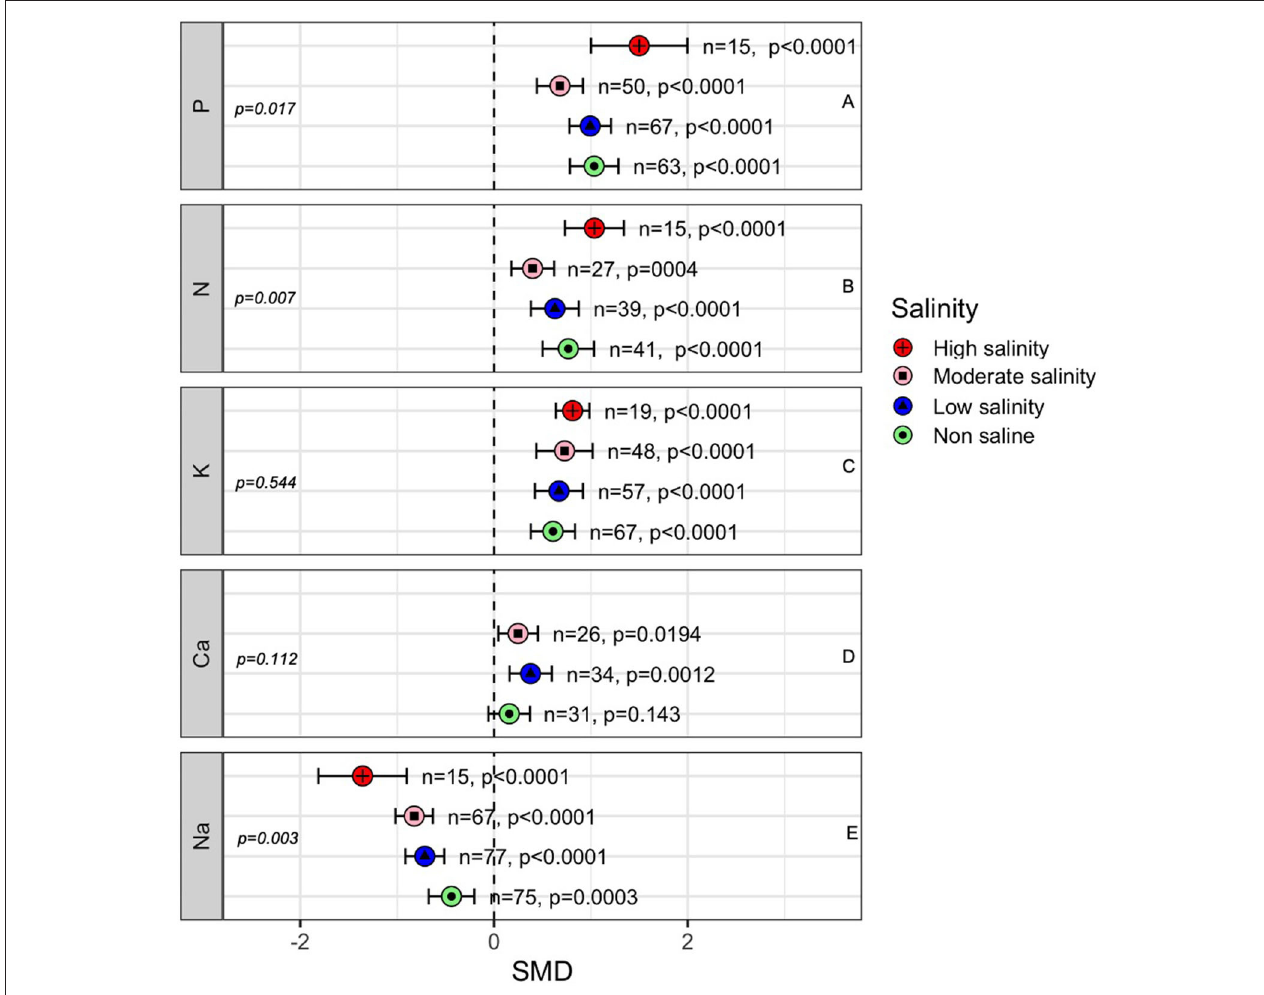
FIGURE 8 | Effects of mycorrhizae on plant nutrient uptake under non-stress, low salinity stress, and moderate salinity stress. Error bars are effect size means CIs. Where the CIs do not overlap the vertical dashed lines, the effect size for a parameter is significant. n , number of studies included in the meta-analysis. Ca, Calcium; K, potassium; Na, sodium; N, Nitrogen and P, phosphorus. n , number of studies included in the meta-analysis; p , significance level of SMD.